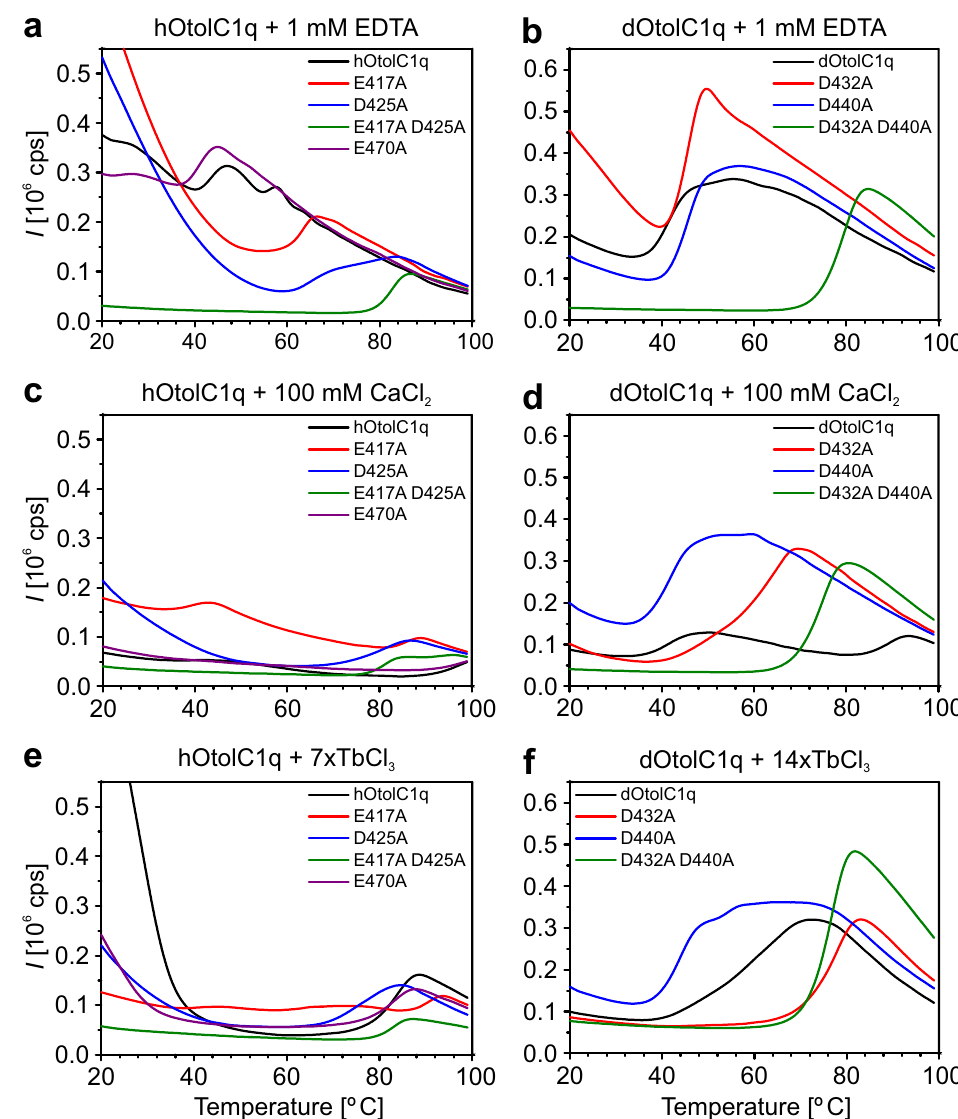
Figure 5. Thermal stability of hOtolC1q, dOtolC1q and their mutants in the presence of Ca 2+ and Tb 3+ . The results of differential scanning fluorimetry (DSF) experiments for ( a , c , e ) 5 µM hOtolC1q, ( b , d , f ) 5 µM dOtolC1q and their mutants in the presence of ( a , b ) 1 mM EDTA, ( c , d ) 100 mM CaCl 2 , ( e ) sevenfold molar excess of TbCl 3 and ( f ) 14-fold molar excess of TbCl 3 . The experiment was conducted in the presence of a 10X concentration (500-fold dilution of a 5000 × stock solution) of SYPRO Orange in an ImageQuant Studio 5 qPCR thermal cycler with heating at 0.033 °C/s. All samples were measured in triplicate, and representative denaturation profiles are